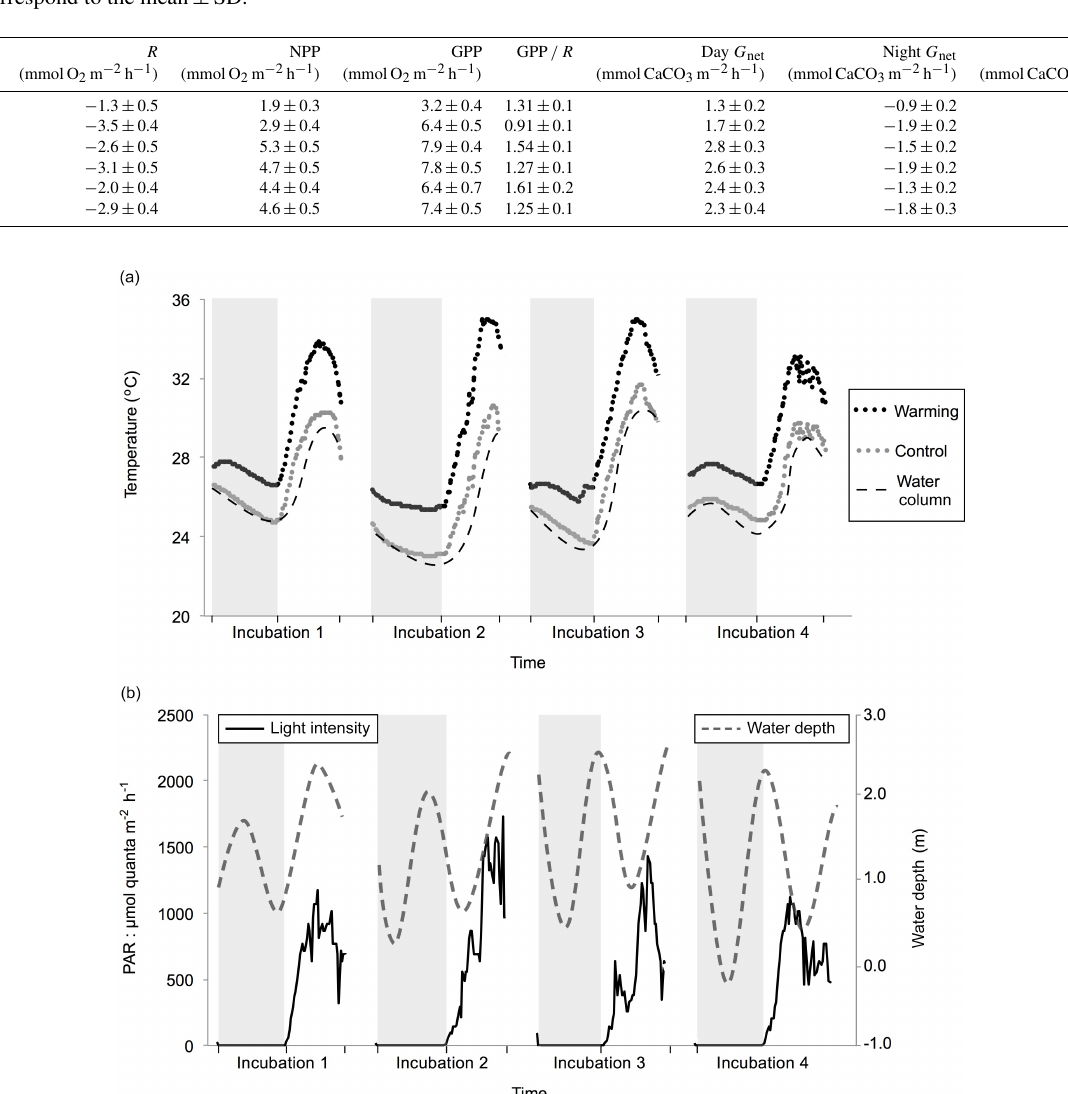
Figure 2. Water column parameters measured during the four incubations, each starting at sunset (18:00) and ending at the following day’s dusk (16:00). Data are presented from the first phase (Incubation 1 and 2) where phytodetritus was used as an organic matter (OM) treatment, and from the second phase (Incubation 3 and 4), where coral mucus was used as an OM treatment. Shaded grey bars represent night-time. (a) Mean temperature ( ◦ C) measured by Hobo temperature recorders that logged temperature at 15min intervals during each incubation period. Data are pooled together as the mean from control (grey dots) and warming (black dotted line) treatments ( n = 4 per incubation). Mean water column temperature ( n = 1 per incubation) shown as a black dashed line. (b) Measured light intensity (µmolquantam − 2 s − 1 ) in the water column (black line) and water height (m) during each incubation period (grey dashed line).